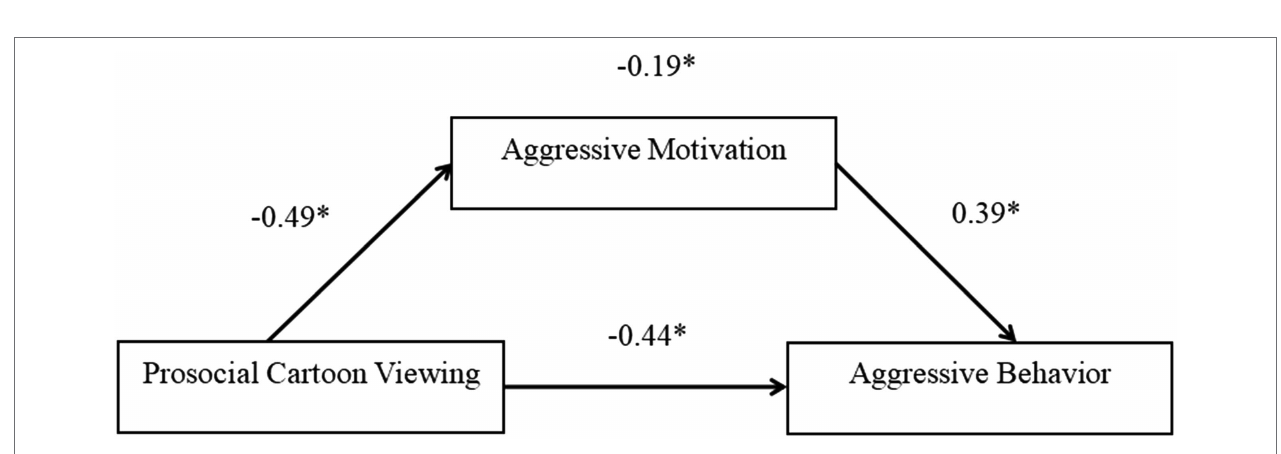
FIGURE 3 | Partial mediation model of prosocial cartoon viewing on aggressive behavior through aggressive motivation for males. 1 = prosocial and 0 = nonprosocial; standardized path coefficients; and solid lines represent significant paths. * p <